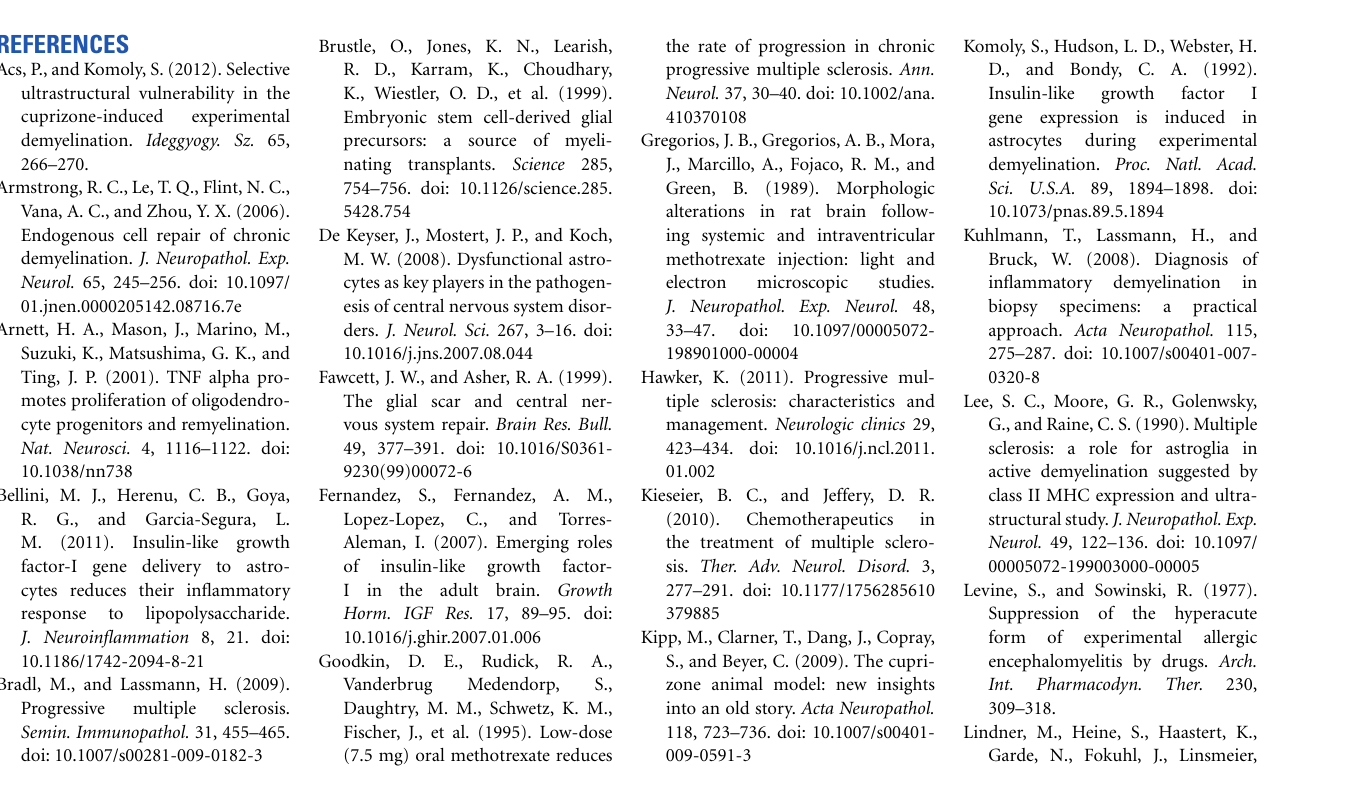
Supplementary Figure 2 | Methotrexate does not affect the length of astroglial processes in the corpus callosum. (A) Top: Representative image of corpus callosum of PBS- treated mouse (600 × magnification). Bottom: Representative image of corpus callosum of icv MTX-treated mouse processes. Six brains slices per mouse were analyzed. Error bars represent standard deviations. Supplementary Table 1 | Genes differentially expressed by CSF cells of ITMTX treated MS patients compared to untreated MS patients. 794 probe sets were upregulated in ITMTX-treated MS patients and 802 downregulated ( p ≤ 0 .